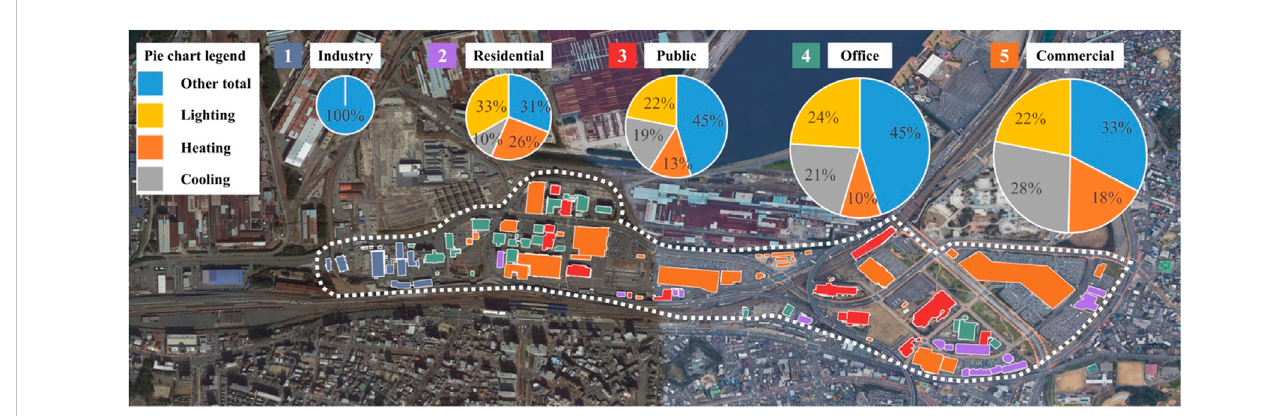
FIGURE 5 Distribution of buildings and structure of electricity consumption in different building sectors.